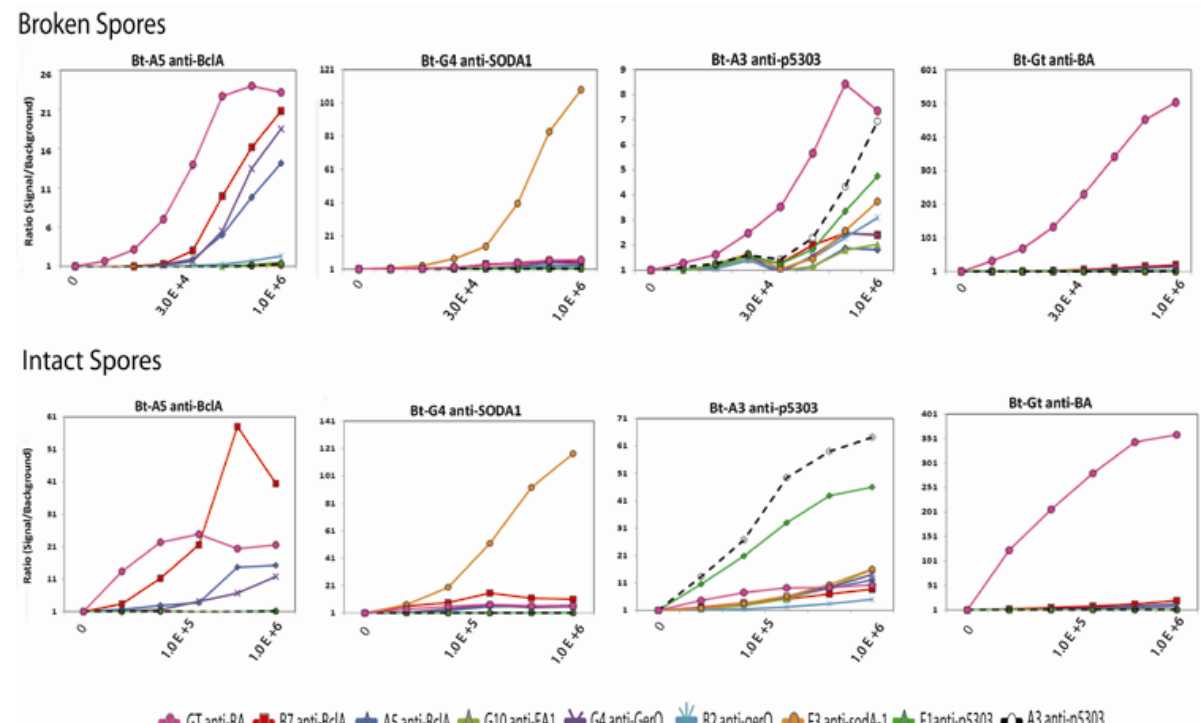
Figure 7. Sandwich immunoassays using four tracers in combination with nine capture reagents for the detection of broken (top) and intact (bottom) B. anthracis spores. Seven of the spore specific sdAbs, BA G10 (a previously isolated anti- B. anthracis sdAb), and a polyclonal goat anti-anthrax antibody were used as captures. The X-axis defines the approximate spore concentration (cfu/mL). The highest concentration (1 × 10 6 spores/mL), an intermediate concentration, and the lowest concentration (no spores) is shown for each data set. Other data points represent a 1:5 serial dilution. Labels were omitted to improve clarity of the